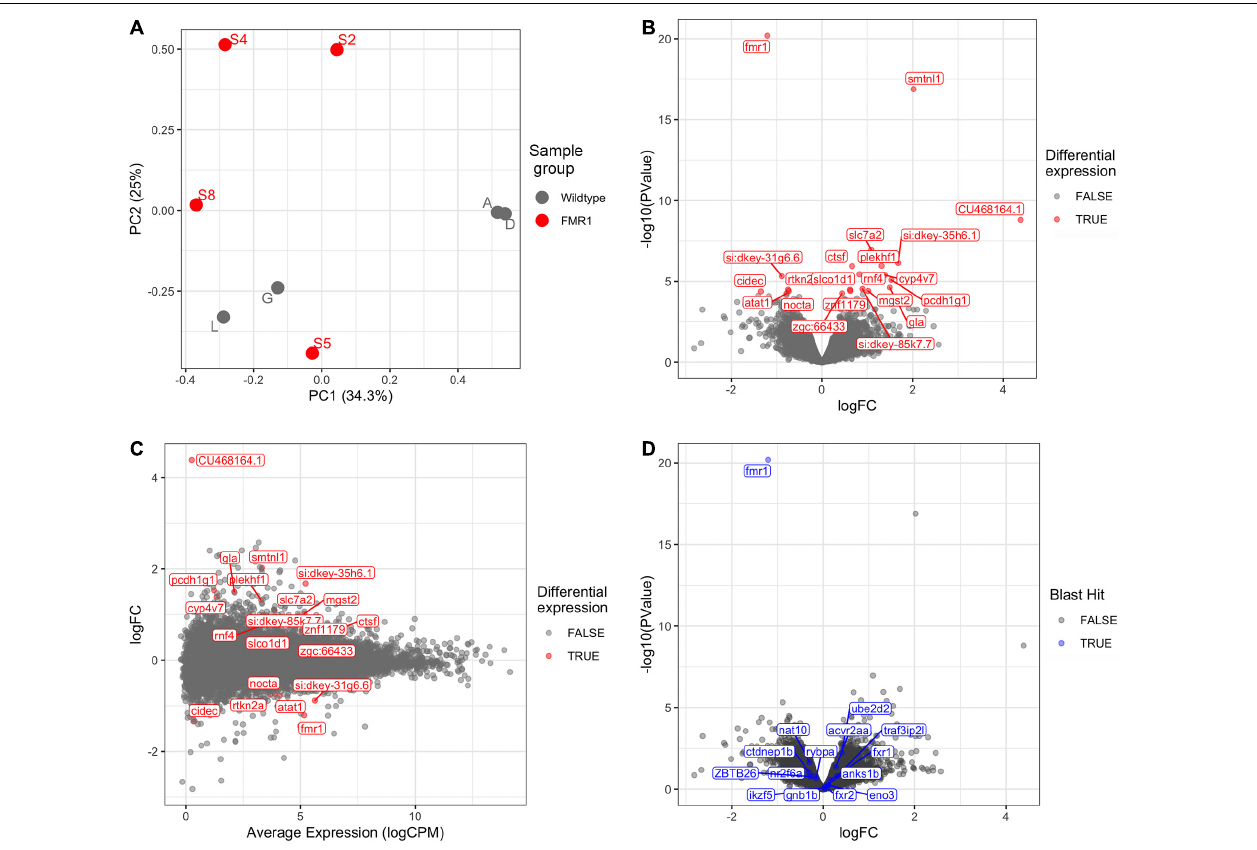
FIGURE 1 | Transcriptome analysis of fmr1 hu 2787 / hu 2787 vs. wild type entire embryos at 2 dpf. (A) Principal Component (PC) analysis of larval wild type (A, D, G, L) and fmr1 hu 2787 / hu 2787 (S2, S4, S5, S8) RNA-seq data. (B) Volcano plot of differential gene expression. (C) Mean-difference (MD) plot showing the average levels of expression of RNAs plotted against fold change differences in expression between mutant and wild type embryos. (D) Volcano plot of differential expression as in b, but indicating genes sharing some degree of sequence homology with fmr1 (indicated in blue). No significantly increased expression is